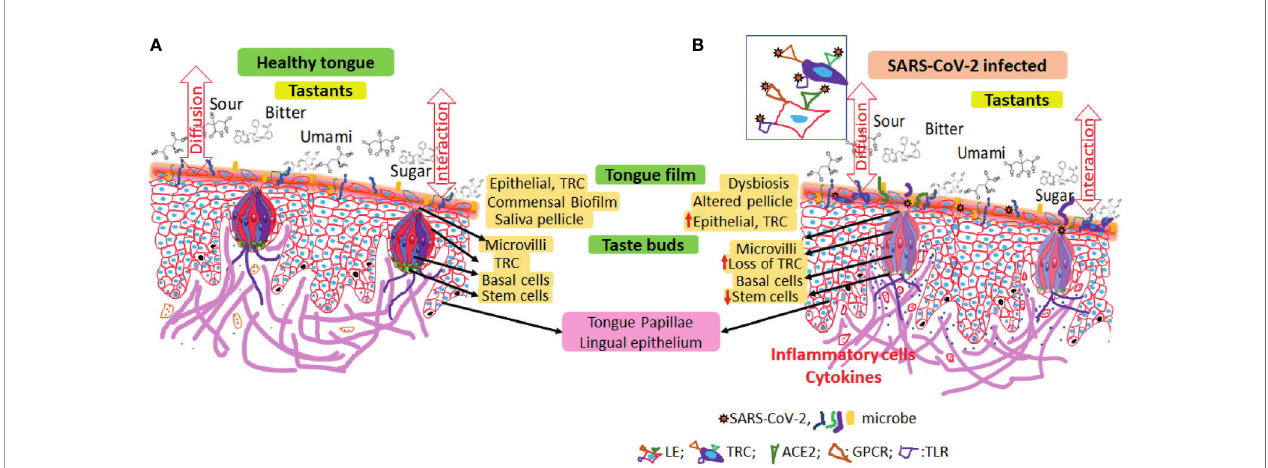
FIGURE 1 | Schematic representationof potential mechanisms for taste dysfunctionin long COVID-19. (A) The lingualepithelium is coveredbya ‘ tongue fi lm ’ that includes extruded/exfoliatedcells, microbiota, and residual saliva. The concentrationof microbialmetabolization products and the cellular density in the tongue fi lm module taste sensitivity. The tastants diffuse through the tongue fi lm either unaltered or modulated bythe microbial metabolizationproducts to reach taste receptor cells throughthe apical opening of the taste buds. Each taste budincludes tightly packed taste receptor cells, supporting (basal)cells as well as stem cells which replenish the continuouslyexfoliating taste receptor cells. Commensal microbiota onthe dorsum of the tongue form organized consortialargely around a core ofkeratinized epithelial cells. Dysbiosis secondary to viral invasiondisrupts the commensal homeostasis (increase pathogenic or opportunistic microbes) and induce innate in fl ammatory responses.Persistent irritation inducedhost responses and increases epithelialproliferation, extrusion, and exfoliation. Pressure onreplenishment for taste receptor cells places increased demand onstem cells and therebycompromises taste budhomeostasis, whichinturn affects taste perception. (B) Inset shows oral epithelialcellsexpressing multiple entry receptors for SARS-CoV-2. LE, lingualepithelium; TRC, taste receptor cells; ACE-2, angiotensinconverting enzyme-2; TLR, toll like receptor; GPCR, G-protein coupled